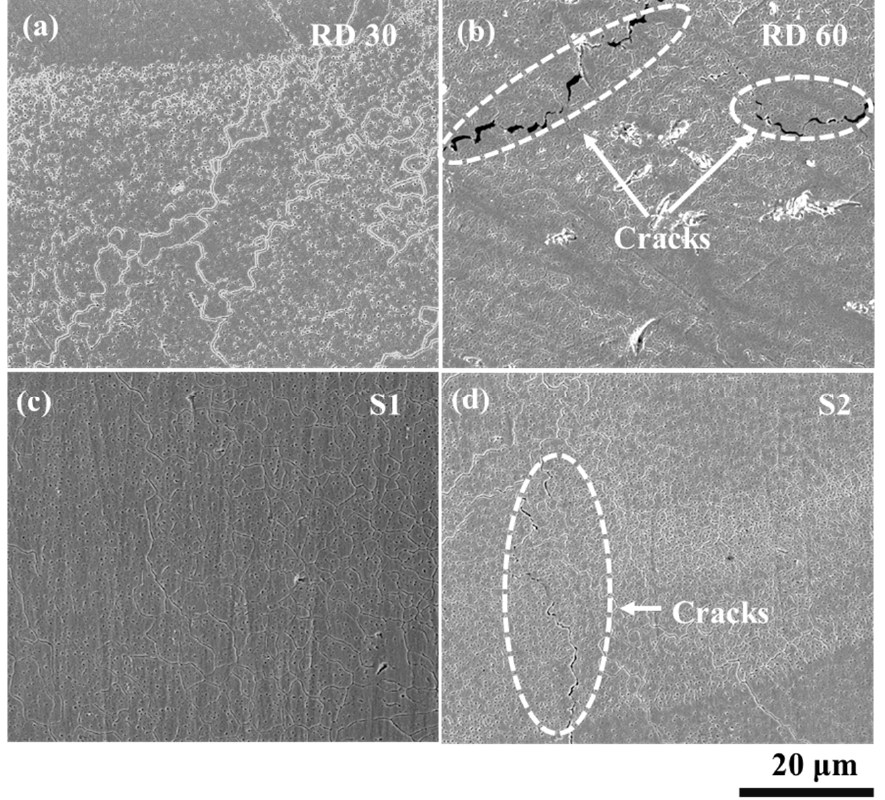
Figure 9. SEM images showing the microstructure of LPBF manufactured primitive lattices NiTi structures with varying relative densities and scan strategies ( a ) RD30, ( b ) RD60, ( c ) S1, and ( d ) S2.